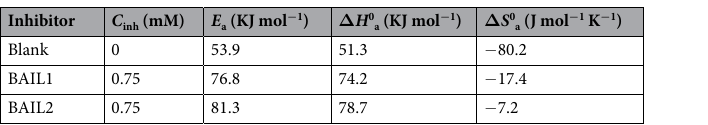
Table 6. The values of activation parameters E a , Δ H 0 a and Δ S 0 a for carbon steel in 0.5 M HCl solution without/ with 0.75 mM BAIL1 and 0.75 mM BAIL2 obtained from WL